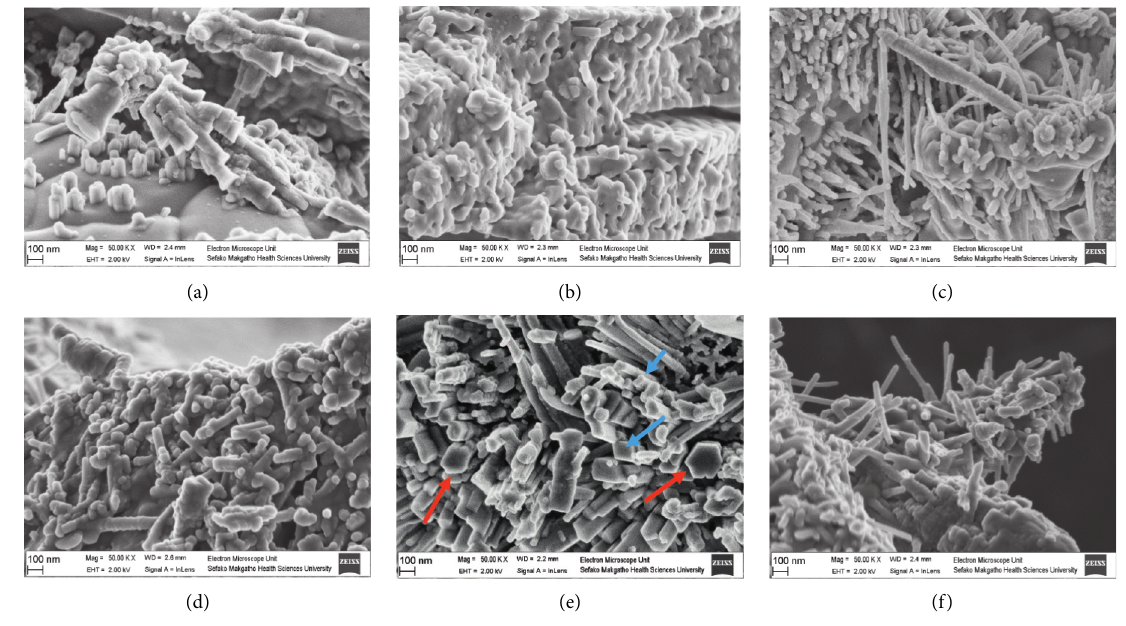
Figure 5: SEM images for (a) BaAl